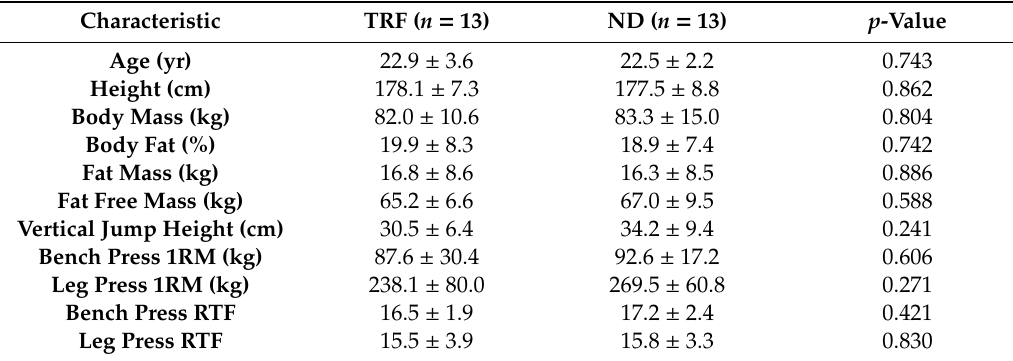
Table 1. Comparison of pretesting participant characteristics.